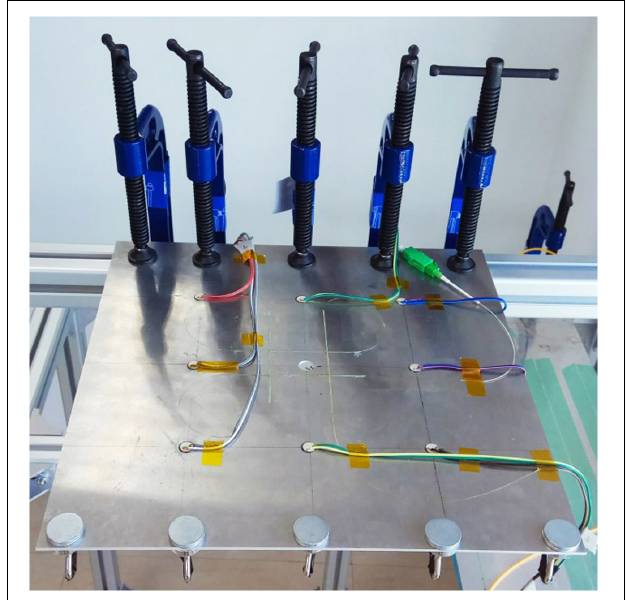
FIGURE 5 | The layout of the fiber-piezoelectric hybrid sensor network.